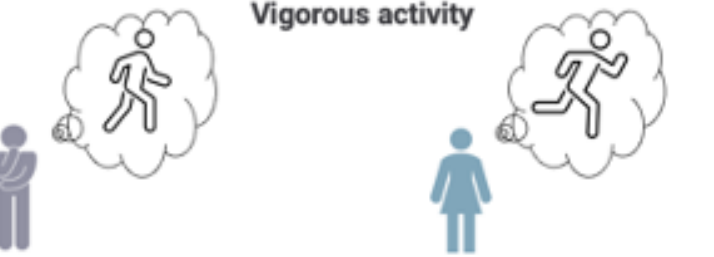
Figure 1. Bill (in grey) interprets items differently compared to others (lack of scalar invariance).